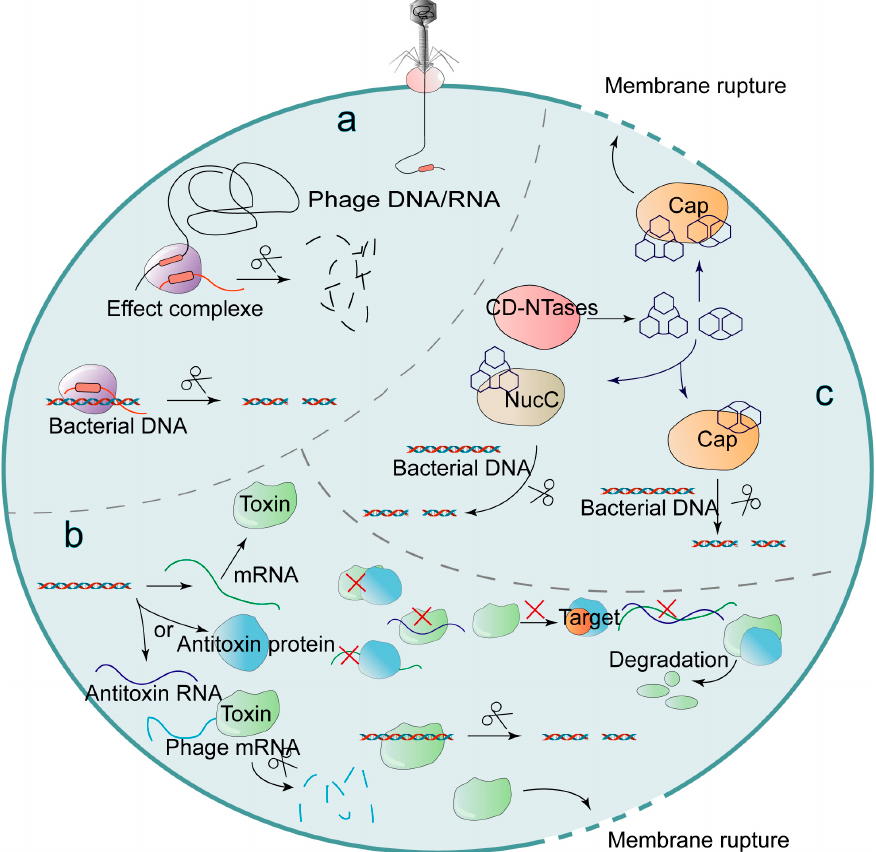
Figure 5. The abortive infection (Abi) systems are based on CRISPR-Cas, cyclic oligonucleotide- based anti-phage signaling system (CBASS) and toxin-antitoxin (TA). ( a ) The Cas proteins with endonuclease activity of CRISPR-Cas, which nonspecifically targets phage genes and bacterial DNA, is thought to be one of the reasons why CRISPR-Cas may mediate Abi in bacteria. However, the exact mechanism by which CRISPR-Cas causes Abi is not yet clear. ( b ) The TA systems are widely present in bacteria and consist of toxins and more unstable antitoxins (the symbol red cross in the figure indicates that the toxin is inhibited). Among them, toxins usually function as proteins to inhibit bacterial growth, and antitoxins function as proteins or RNAs to inhibit toxins. When phages infect bacteria, the TA transcriptional function of the bacteria is hindered and the unstable antitoxin is degraded before the toxin, leading to toxin accumulation. The toxin cleaves the mRNA of the phages. In addition, the toxin cleaves bacterial DNA and mediates the lysis of cell membranes, which leads to bacterial growth arrest or death. ( c ) The cyclic dinucleotide and cyclic trinucleotide synthesized by the cGAS/DncV-like nucleotide transferase (CD-NTase) in the CBASS immune system can promote bacterial membrane lysis or cleavage of bacterial DNA after binding to Cap proteins; the DNA endonuclease NucC in CBASS can cleave bacterial DNA after binding to cyclic AMP-AMP-AMP (cAAA), thus mediating Abi systems.